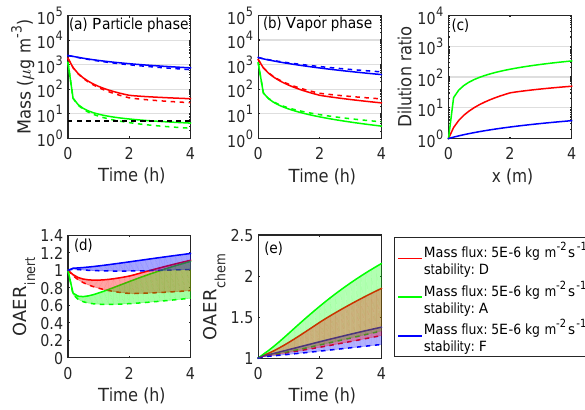
Figure 7. Time evolution during Gaussian dispersion of (a) organic mass (OM) in the particle phase, (b) OM in the vapor phases, (c) di- lution ratio, (d) OAER inert , and (e) OAER chem , with a fire area of 1km 2 , a mass flux (ML) of 5 × 10 − 6 kgm − 2 s − 1 , and assuming different atmospheric stability classes (A, D, and F; see Table 3). The black dashed line on panel a represents the background non- volatile OA concentration (5µgm − 3 )